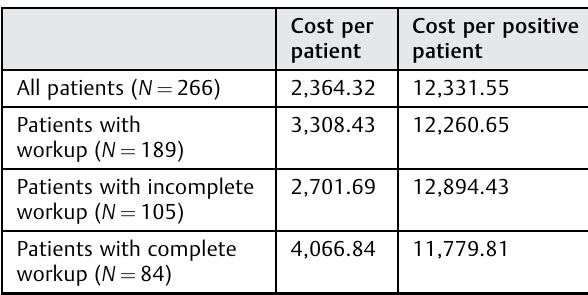
Table 6 Cost of thrombophilia workup (US